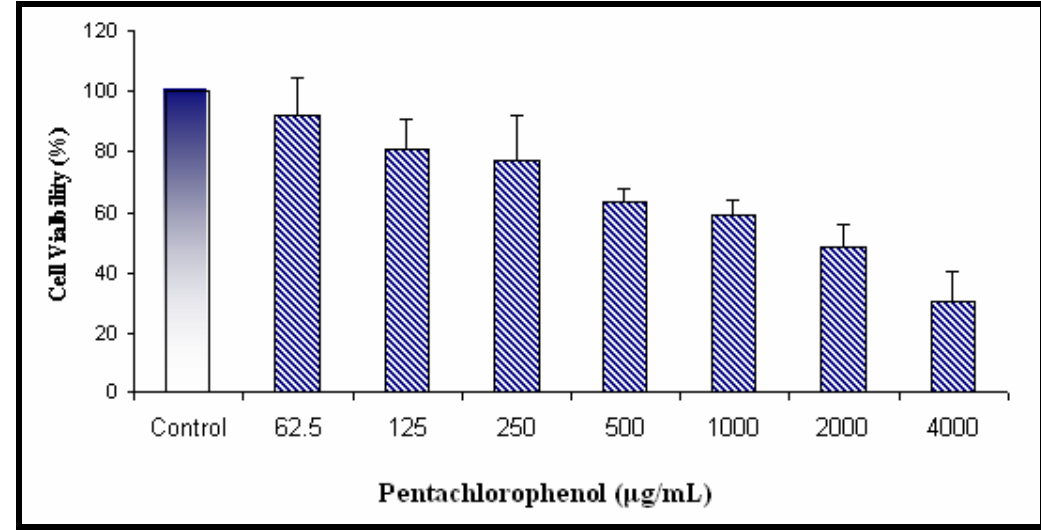
Figure 1: Toxicity of pentachlorophenol to channel catfish hepatocytes. Cell viability of catfish hepatocytes exposed to PCP. The cells were treated with serial dilutions (0-4000 µg/mL) of PCP. Cell viability was measured by FDA assay as indicated in the methodology section. Absorbance readings were converted to percentages cell viability. Bars are means + SDs, n = 3 with 8 replications per concentration. All values are significantly different ( p < 0.05 ) from control (0 µg/mL PCP).